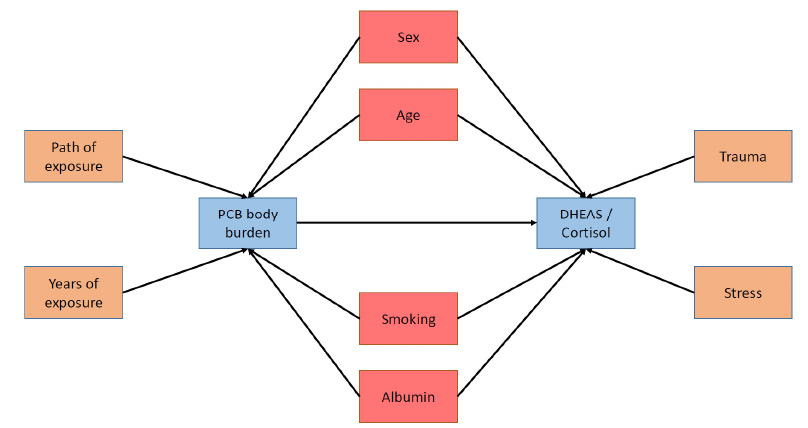
Figure A1. Directed acyclic graph for identifying confounding variables with DAGitty [24].